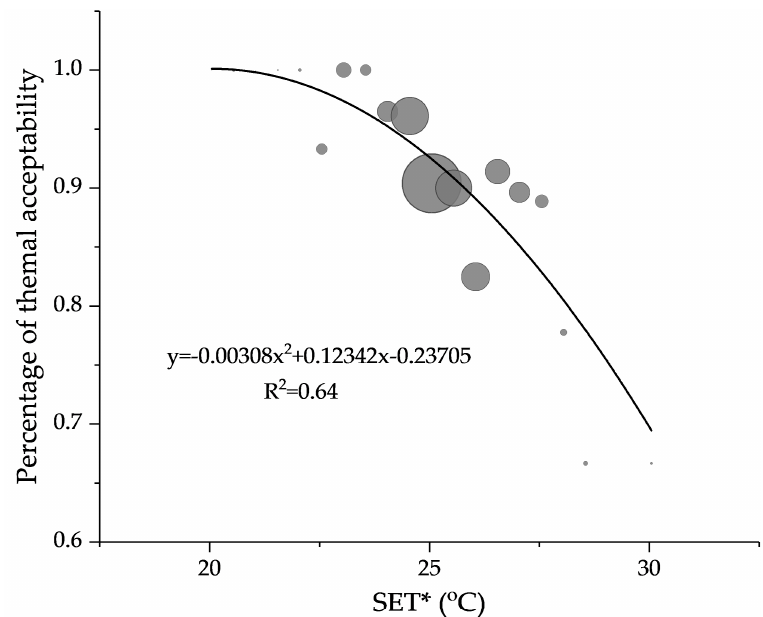
Figure 7. Determination of thermal acceptability in SET*.